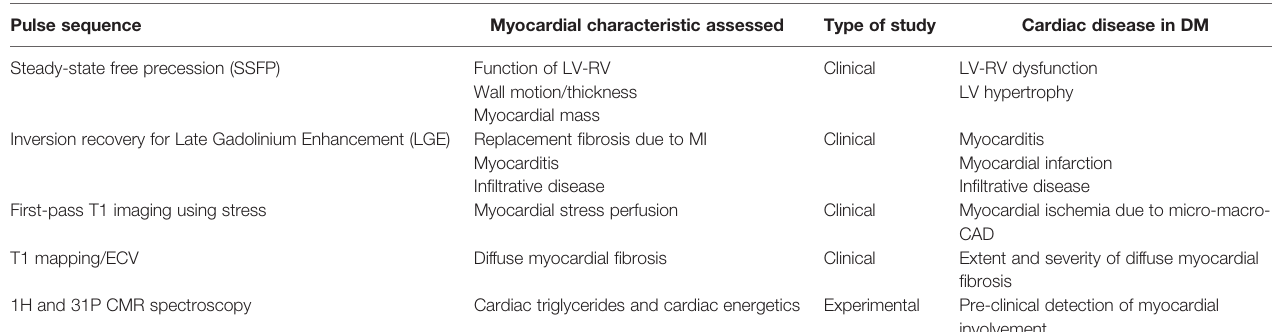
TABLE 1 | CMR sequences for myocardial evaluation in patients with DM. Pulse